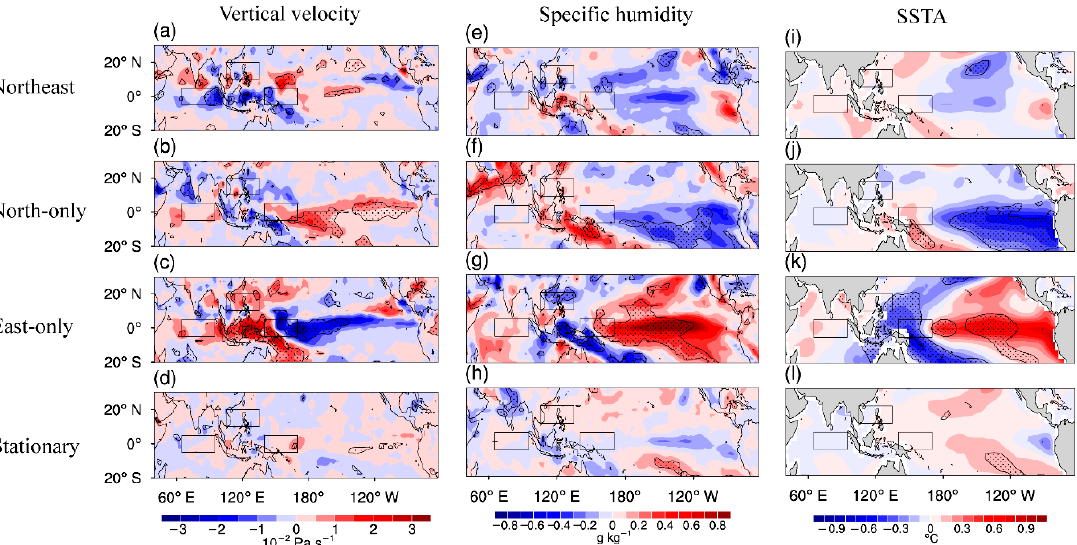
Figure 5. Observed mean state change associated with the four modes. Composite boreal summer (May–September) mean of anomalous 300-hPa to 500-hPa averaged pressure velocity ( a – d ; 10 − 2 Pa s − 1 ), anomalous 850-hPa specific humidity ( e – h ; g/kg), and sea surface temperature anomalies (SSTA) patterns ( i – l ; °C) for northeast, north-only, east-only, and stationary mode years. Stippling indicates the region where anomalies are above the 90% significance level by Student’s t test.